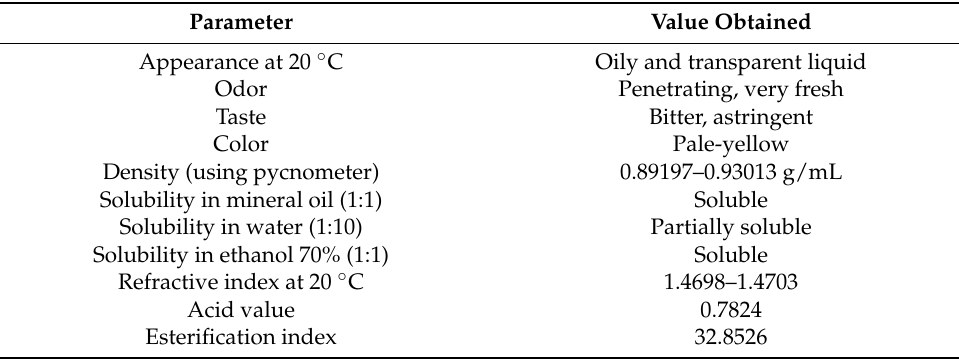
Table 2. Physicochemical parameters of M. armillaris essential